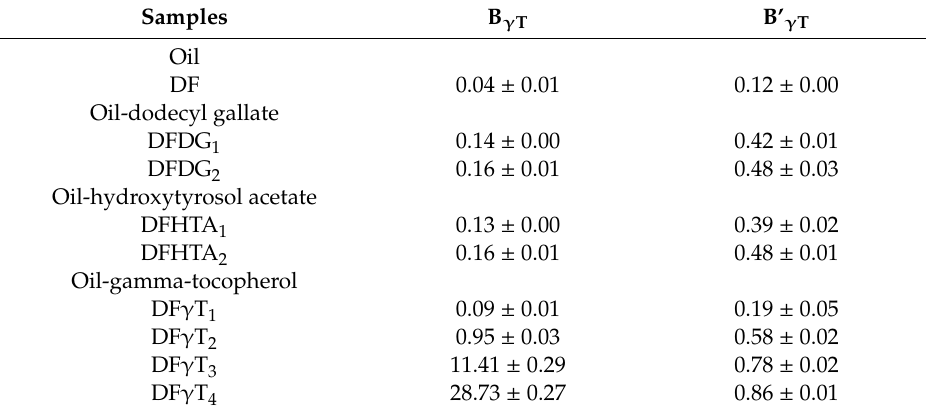
Table 4. In vitro bioaccessibility of gamma-tocopherol in the di ff erent samples, defined by B γ T = mmol ( γ T) D / mol (AF + GA) D and by B’ γ T = mmol( γ T) D / mmol ( γ T) O Values are the average of two determinations together with their standard